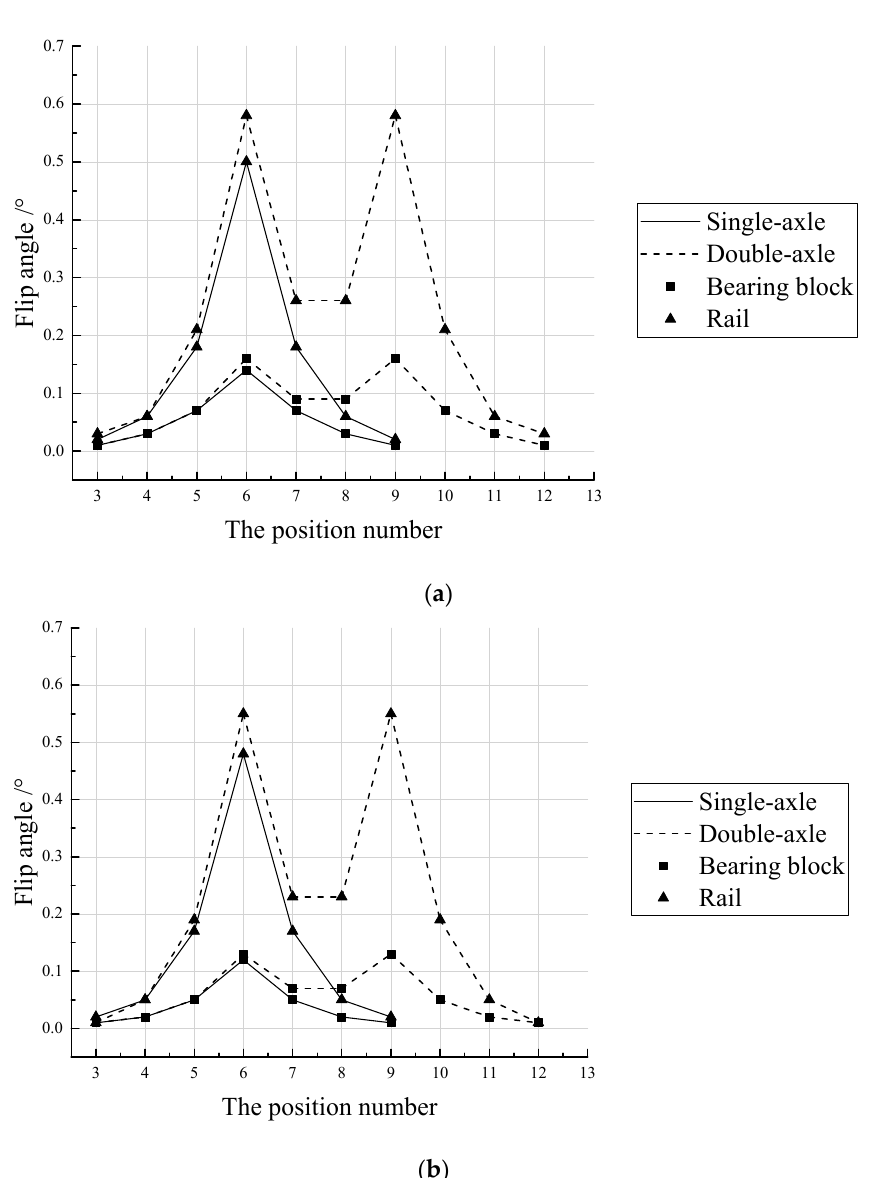
Figure 26. Turning angle of rail and bearing block under lateral and vertical coupled load. ( a ) TLVT. ( b ) ILVT.